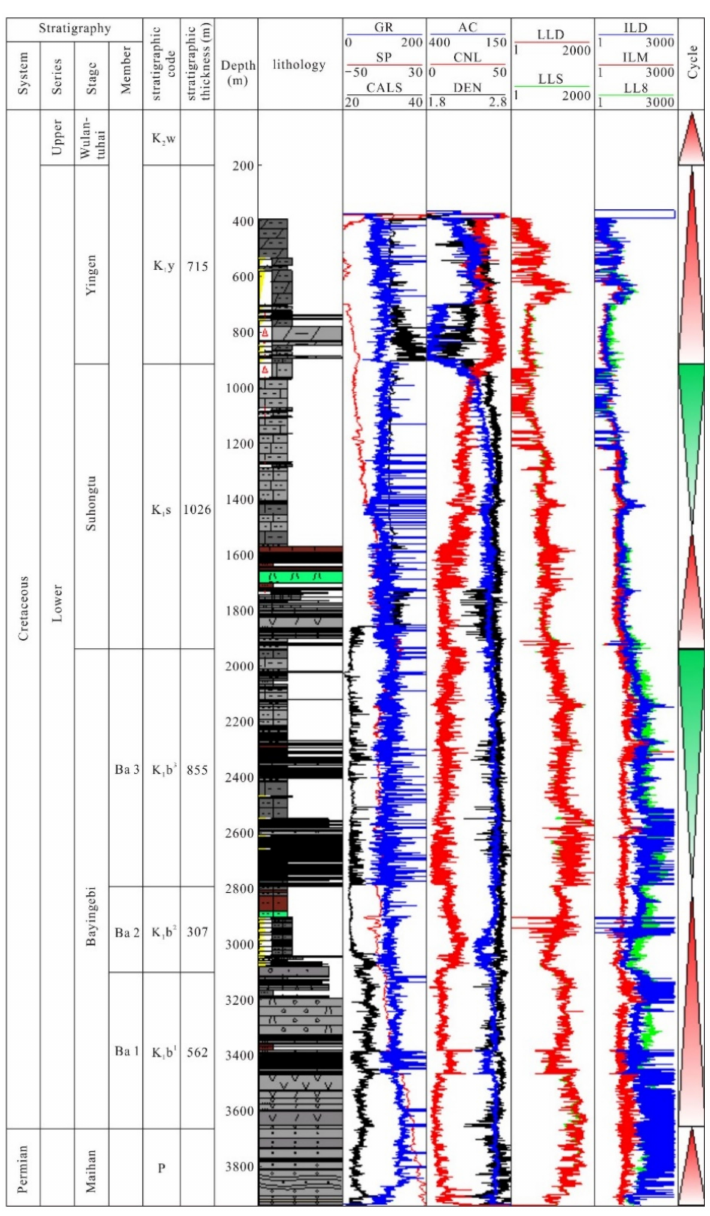
Figure 2. Comprehensive histogram of strata in the Hari